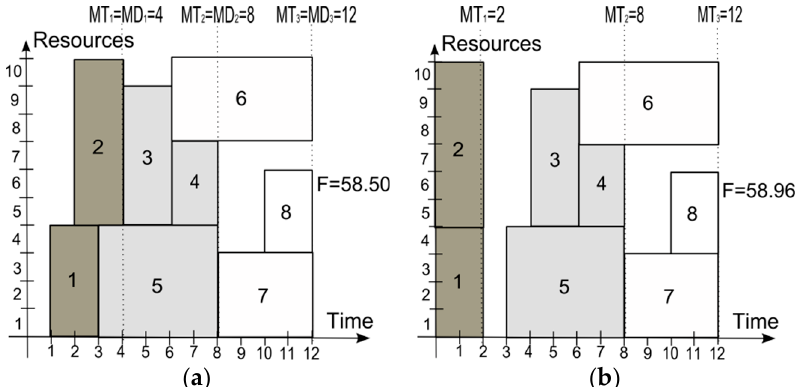
Figure 4. ( a ) Backward schedule for completion times of project stages MT 1 = 4, MT 2 = 8, MT 3 = 12, ( b ) schedule determined as a result of optimization of the completion time of first stage with MT 1 = 2, MT 2 = 8, MT 3 =